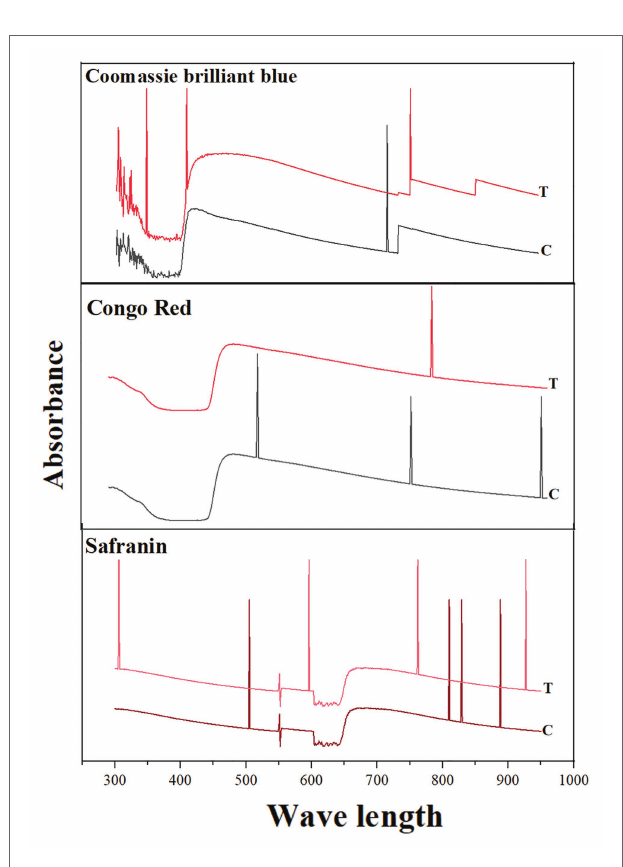
FIGURE 4 | Spectrophotometric analysis of dye decolorization by S. kushneri HTSP. Here, Control indicates dye before decolorization and test indicates dye after decolorization. CBB for CBB